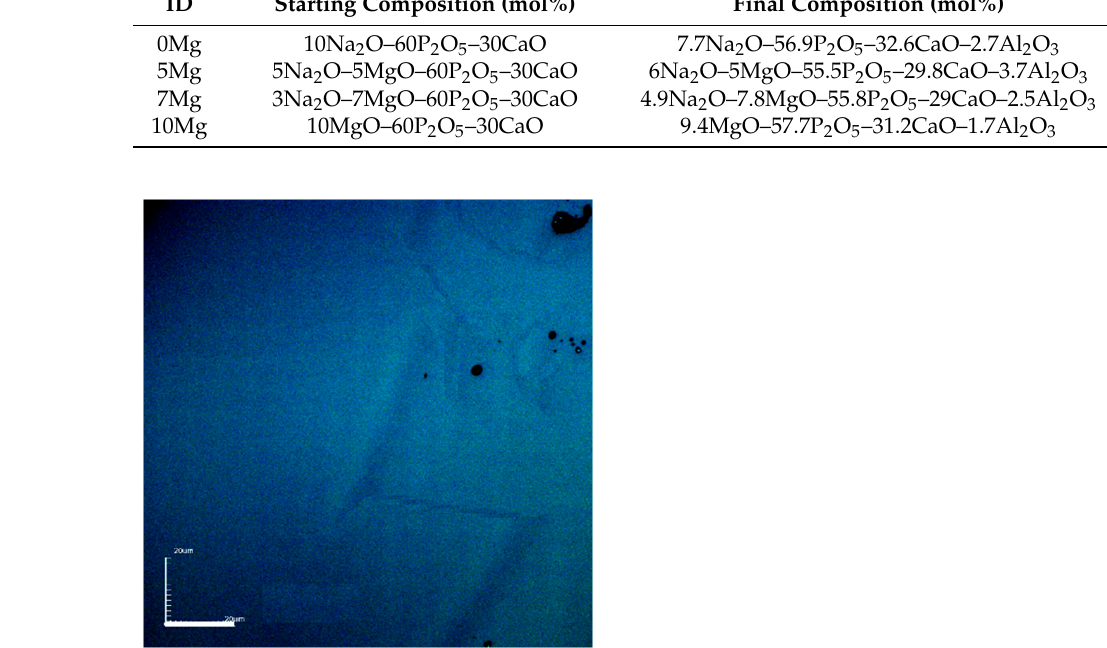
Figure 1. CSLM micrograph for sample 5Mg (see Table 1 for details). Scale bar is 20 μ m. Table 1. IDs, starting and final compositions of all